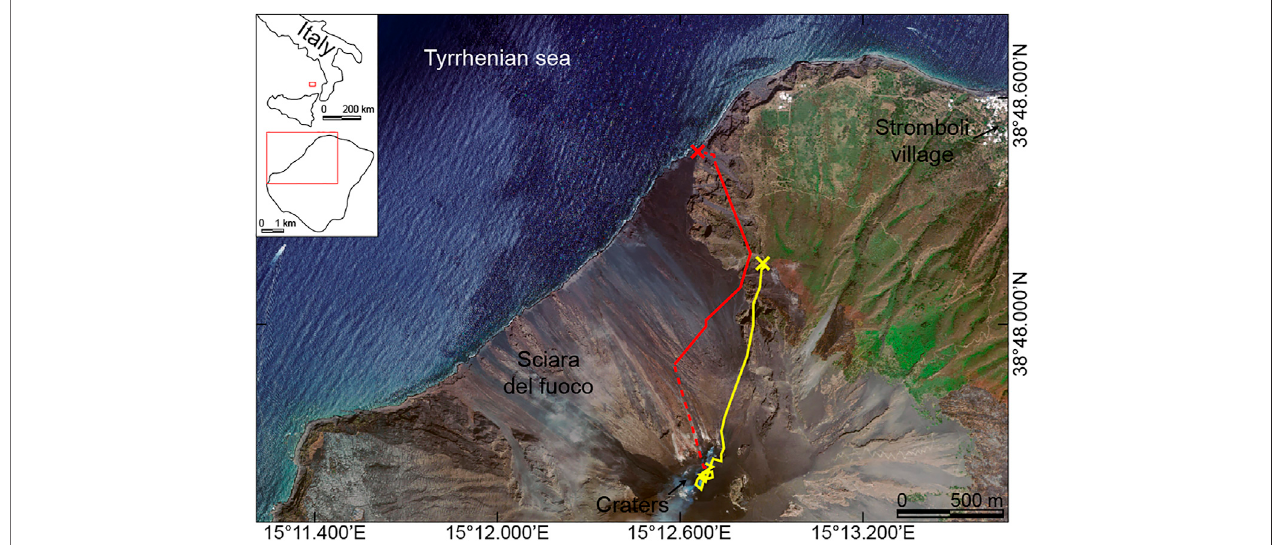
FIGURE 2 | Sentinel-2 satellite image of the north-western section of Stromboli volcano, showing the fl ank collapse area and the summit crater regions. Yellow cross andlines depict thetake-offlocation and fl ightpath, respectively.Red lines (dashedand non)showthe fl ightpathofthesUAVwhile beingirresponsiveandpartially responsive, respectively. Red cross marks the location the sUAV was recovered